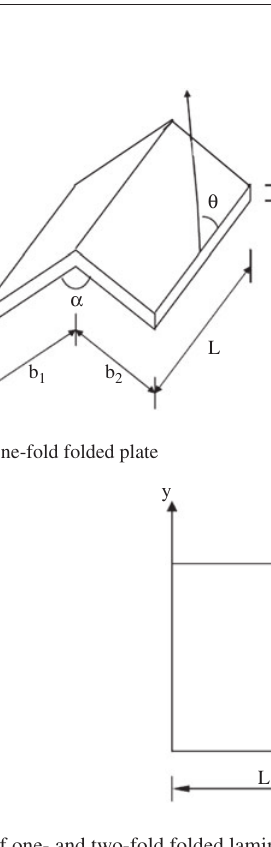
Figure 2 Geometry of one- and two-fold folded laminated plates.